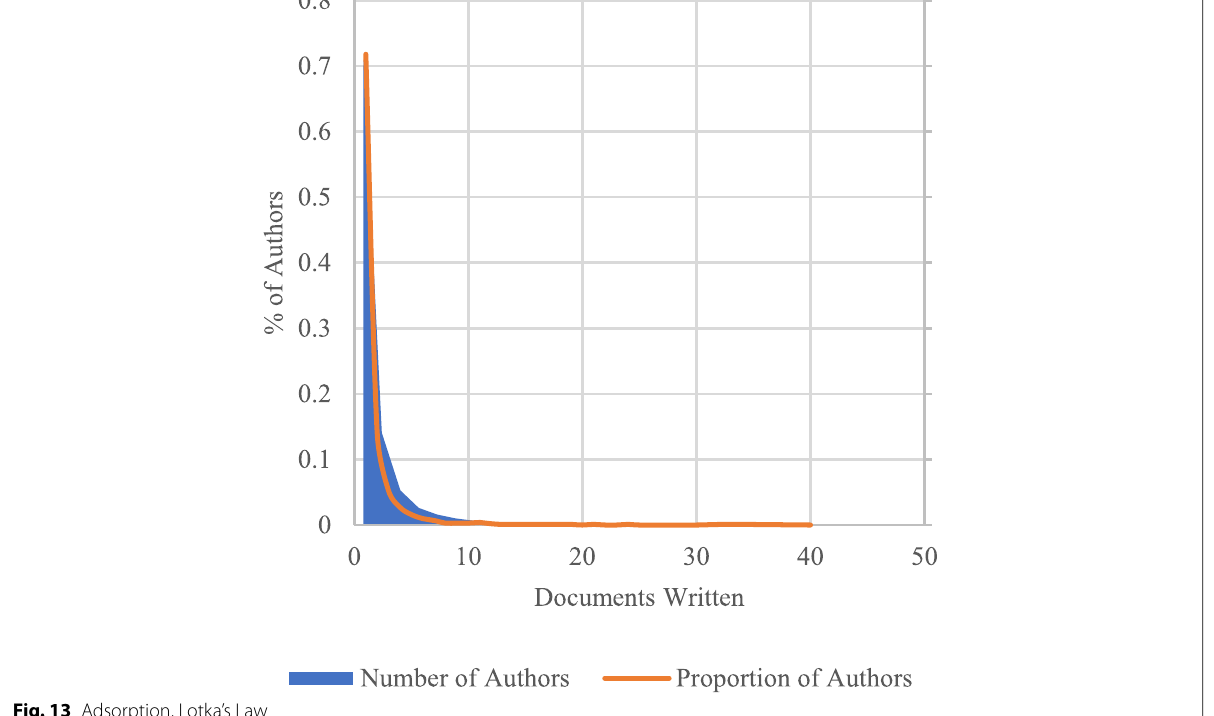
Fig. 13 Adsorption, Lotka’s Law